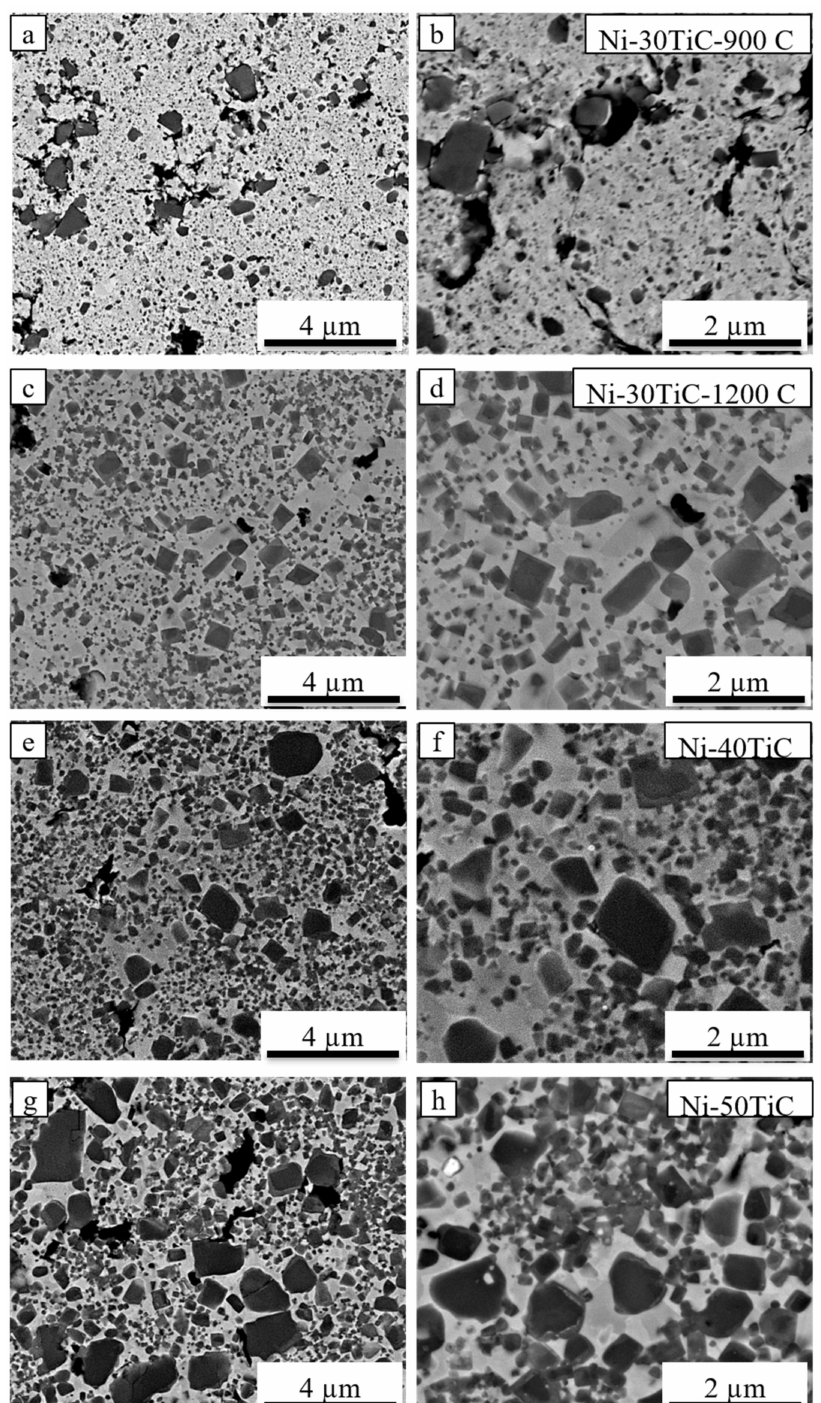
Figure 3. Scanning electron microscopy images ( a , b ) Ni-30TiC at 900 ◦ C, ( c , d ) Ni-30TiC at 1200 ◦ C, ( e , f ) Ni-40TiC, and ( g , h ) Ni-50TiC